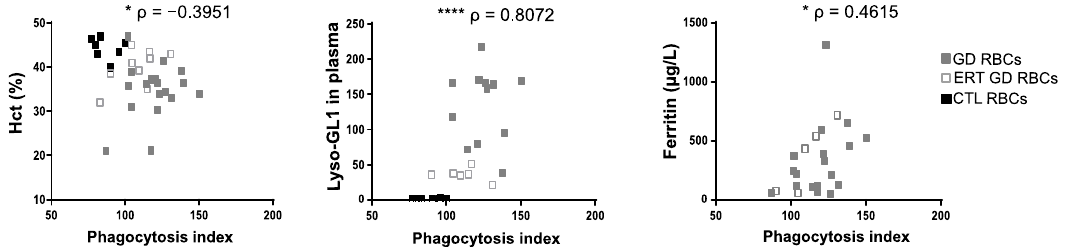
Figure 5. The enhanced phagocytosis of GD RBCs correlates with markers of disease activity. The PI of RBCs negatively correlated with the percentage of the hematocrit (Hct) (left panel) and positively correlated with the Lyso-GL1 (middle panel) and ferritin (right panel) plasmatic concentration. GD, ERT GD, and CTL RBCs values are depicted with gray, white and dark squares, respectively. The p and ρ values were determined using the Spearman rank correlation test. * p < 0.05; **** p <